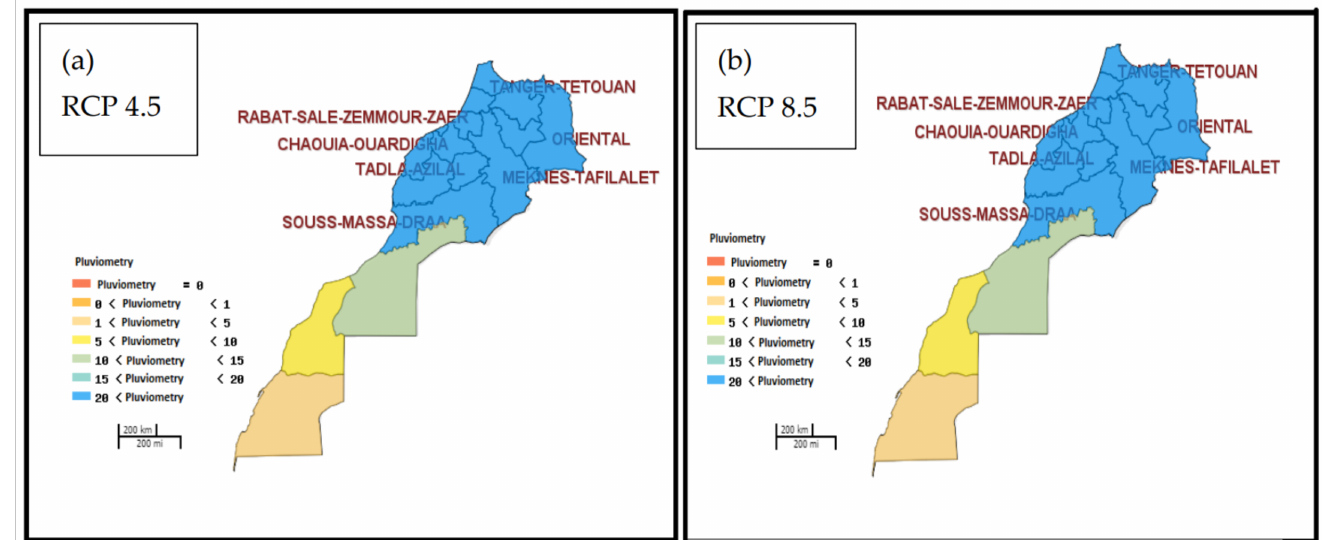
Figure 2. Spatial distribution of pluviometry across Morocco under ( a ) and ( b ).